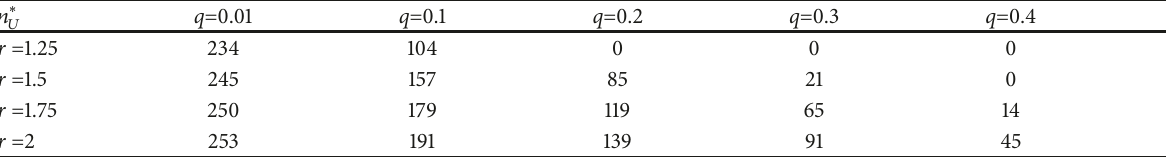
Table 5: The sensitivity of optimal unreliable facility quantity to q (0.01, 0.5) and r (1.25, 2).